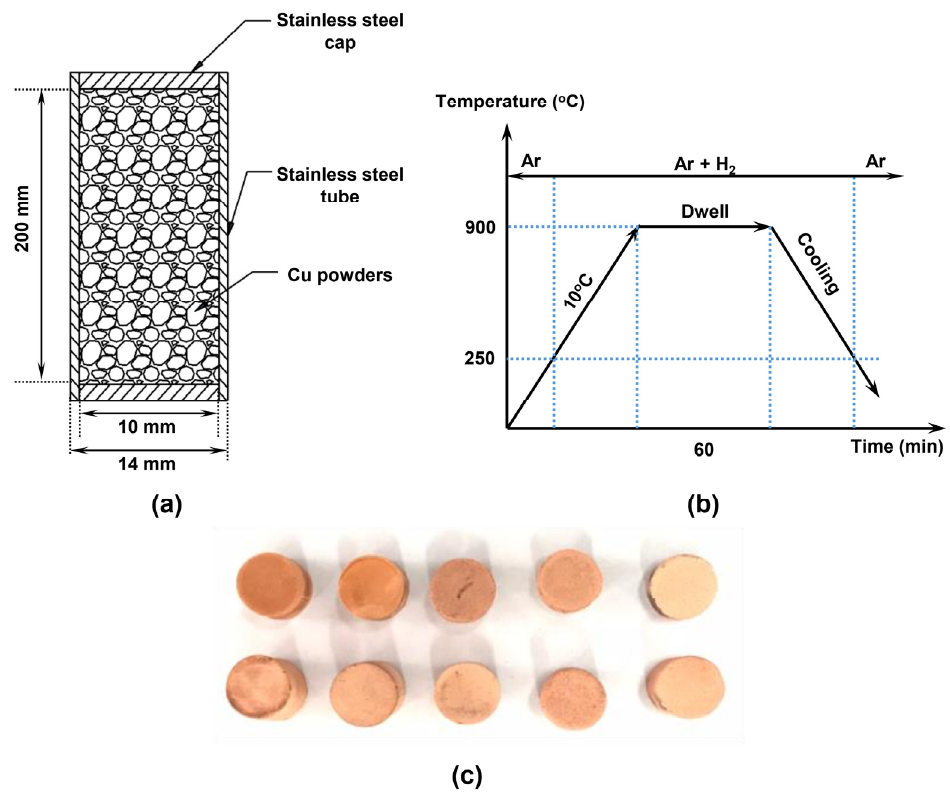
Figure 1. ( a ) Mold for preparing porous Cu, ( b ) sintering process, and ( c ) porous Cu prepared by using the loose-powder sintering process.